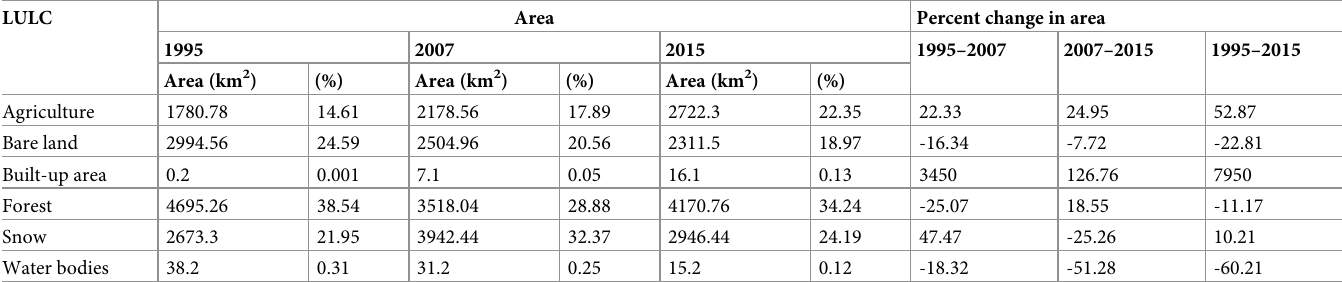
Table 4. Distribution and percent change in LULC through the years 1995, 2007 and